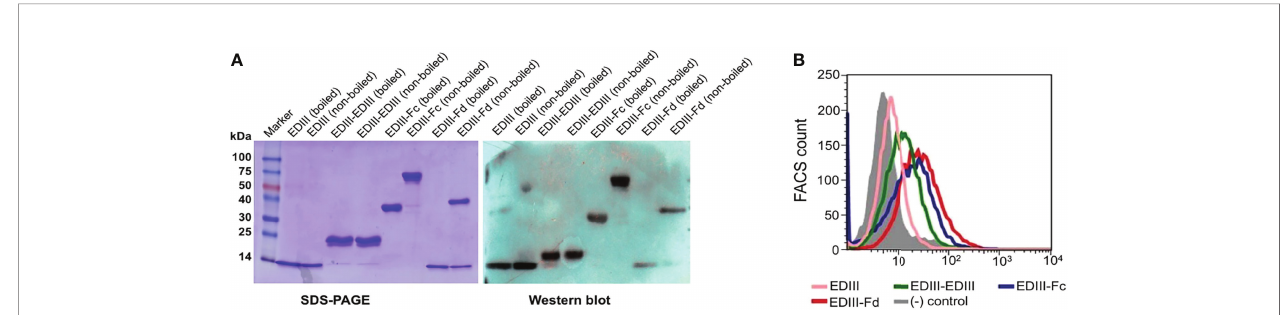
FIGURE 2 | Biochemical characterization of recombinant JEV EDIII fragments. (A) SDS-PAGE and Western blot analyses of puri fi ed recombinant EDIII fragments. Protein samples (10 m g) were either boiled at 95°C for 5 min or not boiled, and then subjected to either SDS-PAGE and Coomassie blue staining (left) or Western blot and recognition by an EDIII-speci fi c mAb (right). (B) Flow cytometry analysis of the binding of recombinant EDIII fragments to JEV-susceptible Vero cells. Cells were sequentially incubated with either one of the recombinant EDIII fragments (20 µg/mL) or BSA control (gray shade), followed by incubation with either FITC- labeled anti-human IgG (for EDIII-Fc) or anti-His tag antibody (for EDIII, EDIII-EDIII, EDIII-Fd).